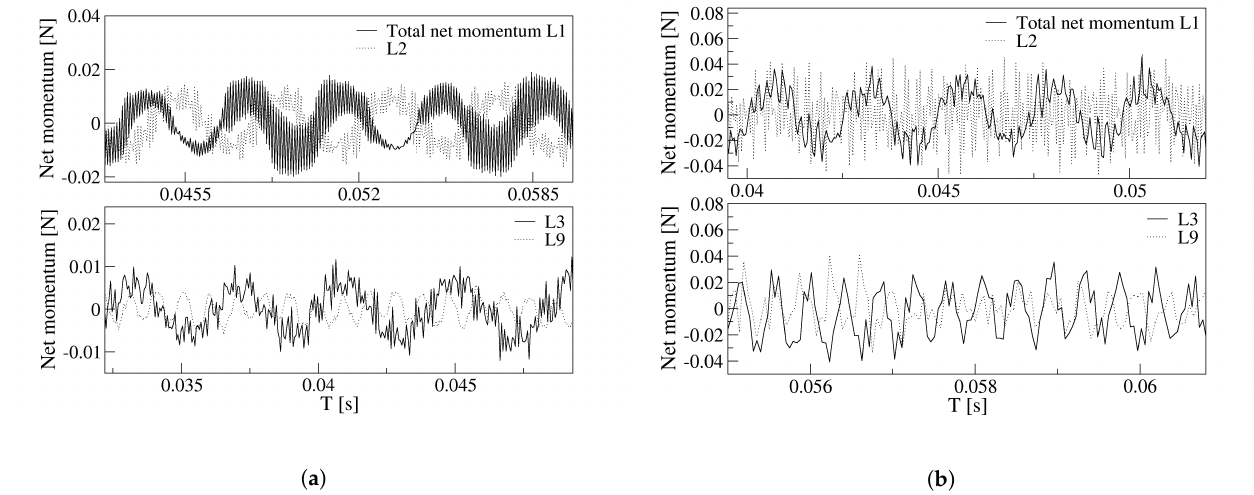
Figure 11. Net momentum applied to the jet entering the mixing chamber as a function of the different feedback channels length. ( a ) Power nozzle velocity, 65 m/s. ( b ) Power nozzle velocity, 97